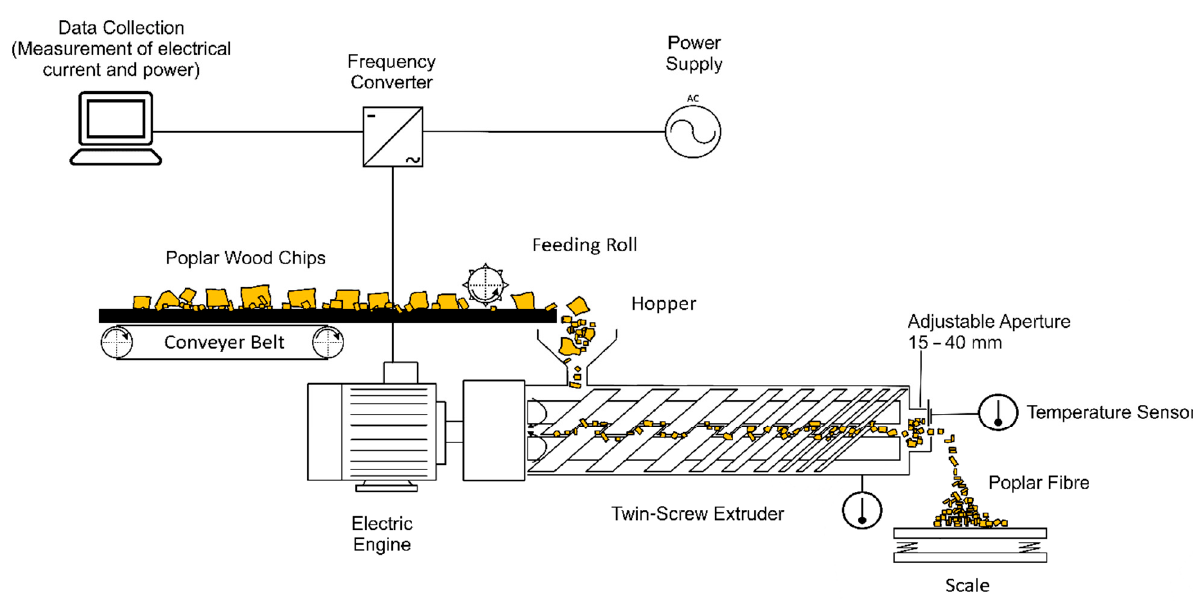
Figure 1. Experimental design of fibre processing in a twin-screw extruder.